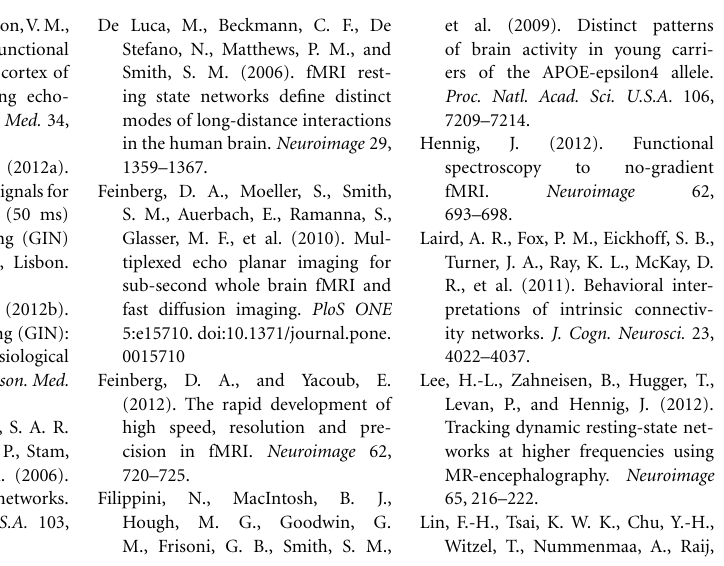
and GIN is the abundance of physiological noise related com- ponents obtained with regular ICA as they dominate the total variance in the data. The dual regression approach used in the study enabled to directly obtain network specific frequency spectra and overcome the disadvantages of GIN and low TR acquisitions. Studies related to temporal ICA (Smith et al., 2012) and the high frequency content of RSNs (Niazy et al., 2011; van Oort et al., 2012)wouldcertainlybenefitfromthelargenumberof timepoints obtained with GIN in relatively short scan